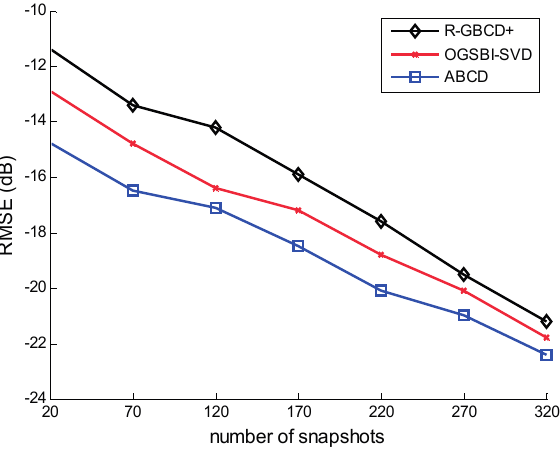
Figure 4. RMSE vs. SNR with the fixed number of snapshots 100.